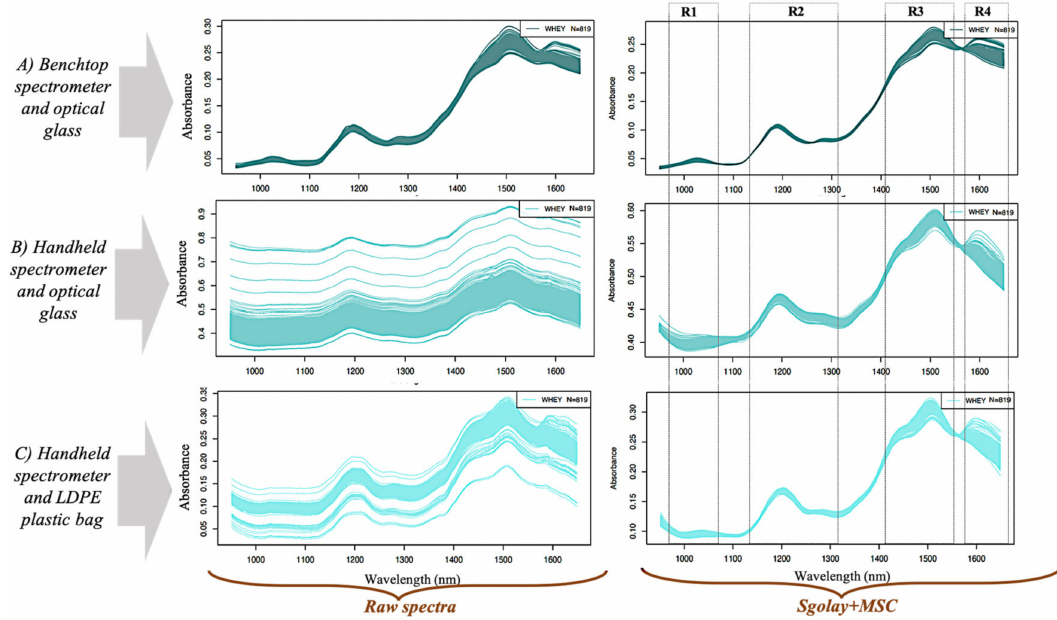
Figure 1. Raw and pretreated di ff use reflectance absorbance spectra plots of pure and adulterated whey protein powder samples scanned with the benchtop spectrometer and handheld spectrometer at the wavelength range of 950–1650